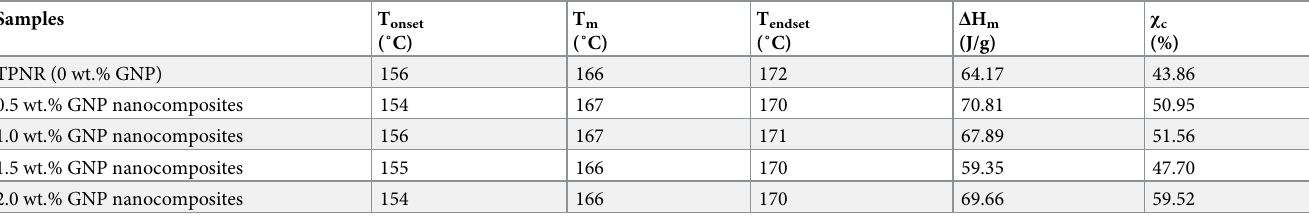
Table 2. Thermal property characteristics of TPNR and TPNR/GNP nanocomposites obtained from DSC. Samples